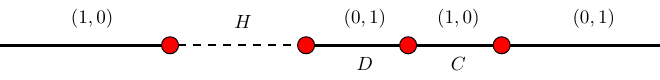
Figure 1 . Rod diagram of black hole and bubble spacetime. The pair of integers above each interval speci(cid:12)es the combination of @ ; @ (cid:30) which vanishes there in the basis ( v + ; v (cid:0) ). The original BMPV solution is recovered by taking k removes the nontrivial topology outside the